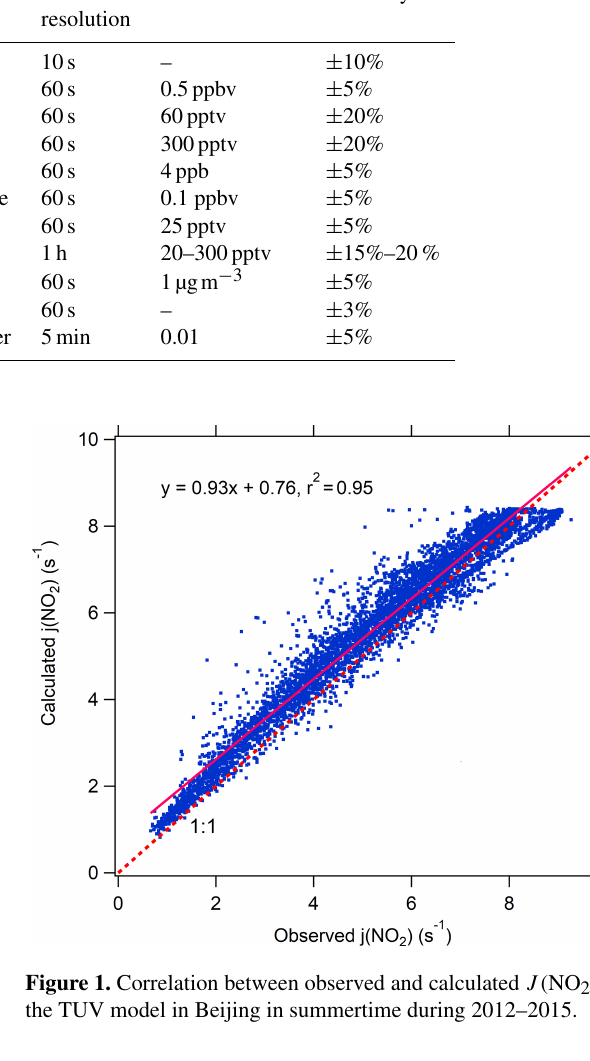
Table 1. Instruments deployed in the measurement campaign undertaken in August during 2005–2016 and used for data analysis. Parameters